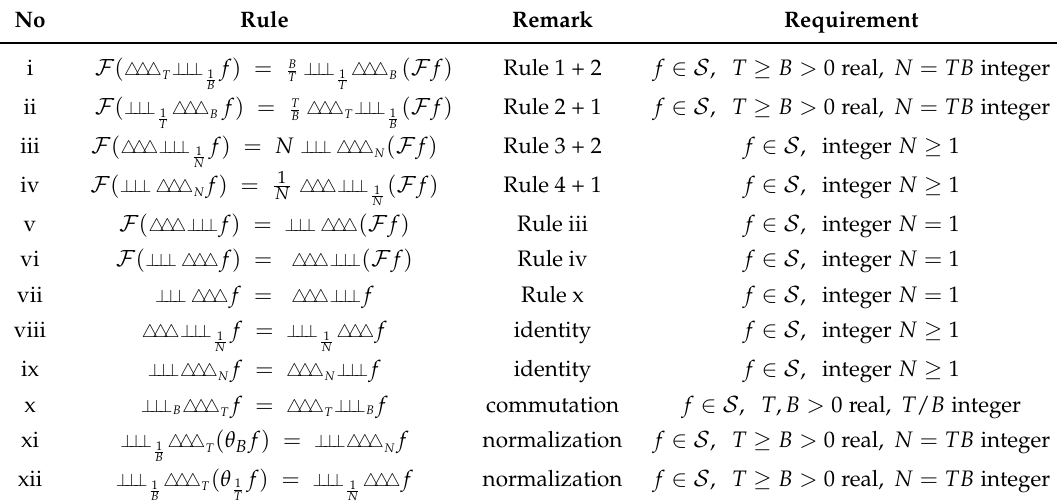
Table 3. Discrete Periodic